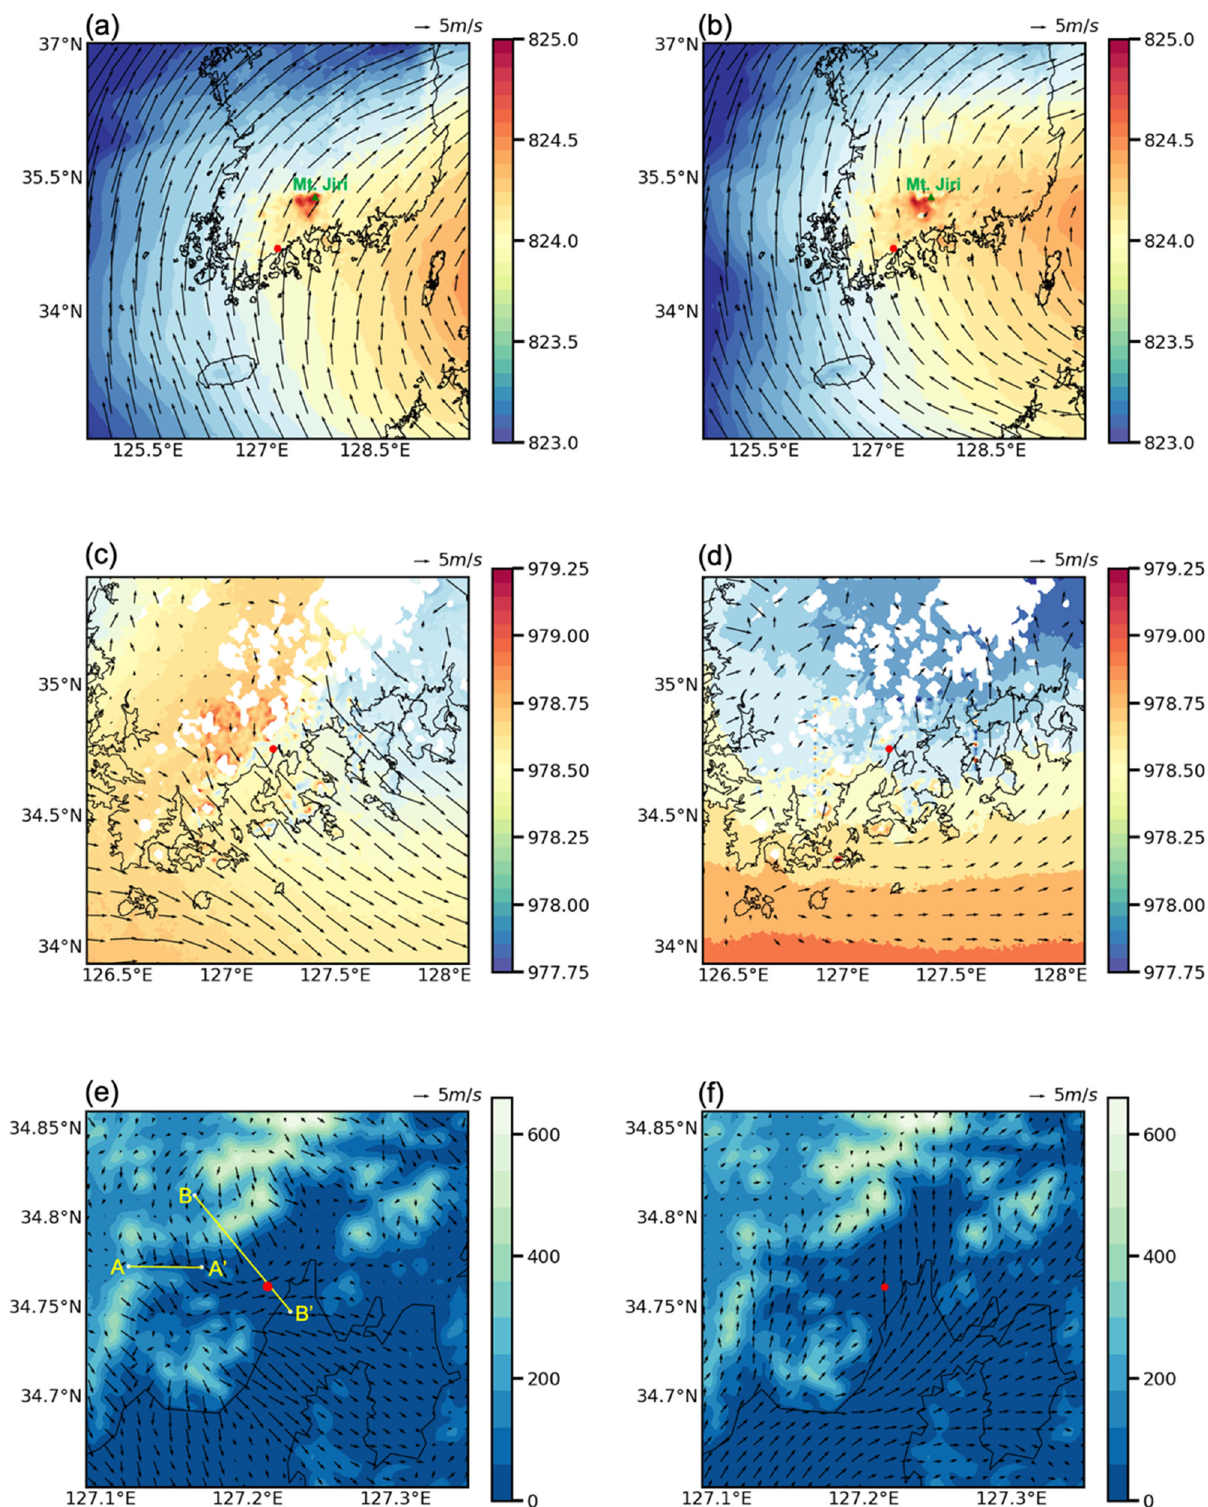
Figure 6. Horizontal distribution of horizontal wind and pressure (hPa) at 1800 m AGL for D02 ( a , b ), at 300 m AGL for D03 ( c , d ) at 05:30 ( a , c ) and 14:30 LST ( b , d ), and horizontal distribution of 10-m wind vectors with topography (m) in the analysis domain at ( e ) 05:30 LST and ( f ) 14:30 LST. A red dot indicates the location of the BSWO. White color in ( c , d ) indicates high-elevation areas with terrain height of more than 300 m